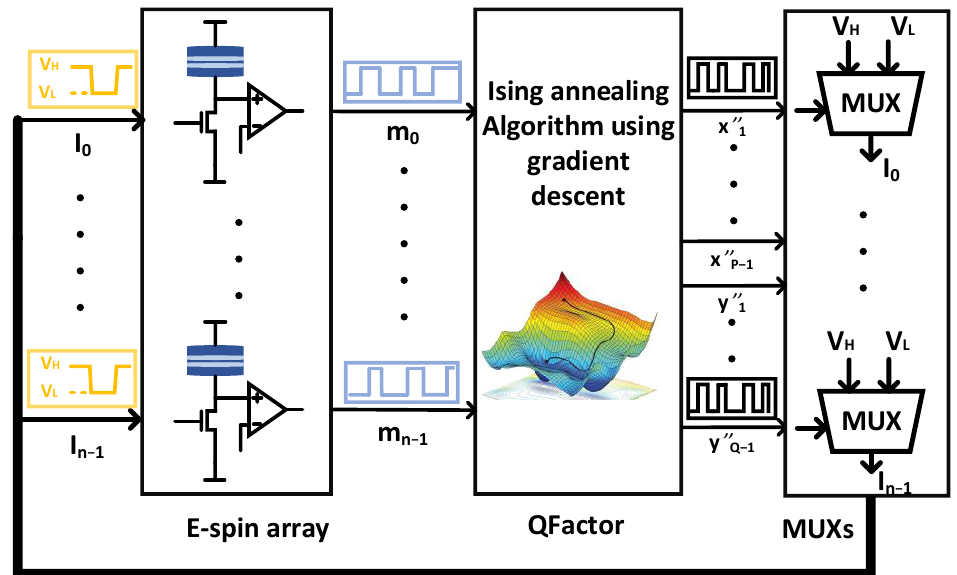
Figure 6. The overall diagram of the proposed Ising annealing system (QFactor). It comprises an E-spin array with 64 E-spins, a digital circuit to implement the QFactor annealing algorithm, and analog MUXs.